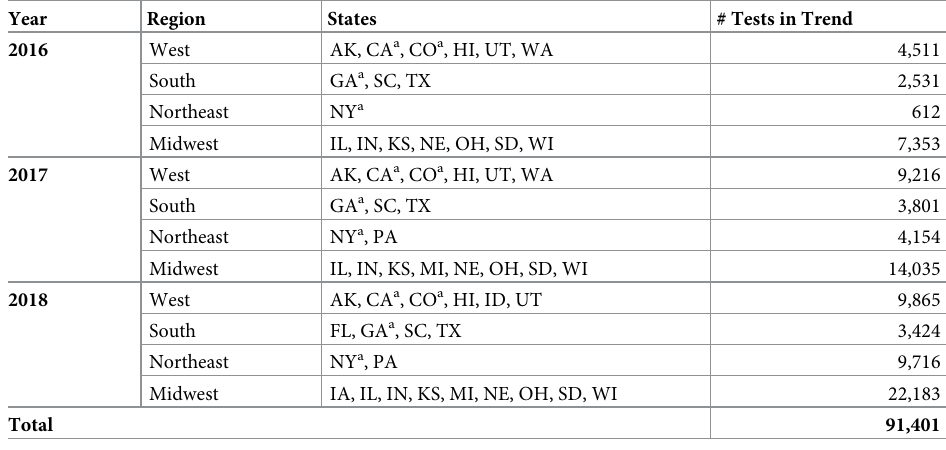
Table 1. Distribution of test number by United States region and year (N = 91,401) for the 29 clinical